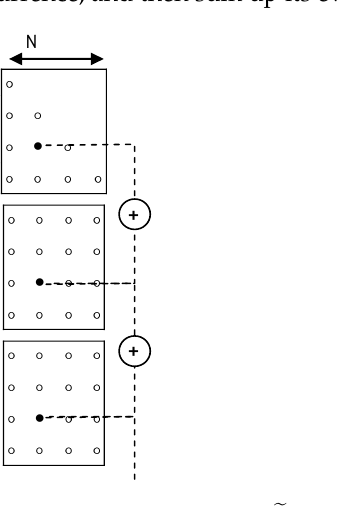
Figure 3. Method to determine (cid:101) h n , m elements of matrix H . The cycloparametric matrix can also be determined directly by inverting the filter’s steady state matrix, provided the system is